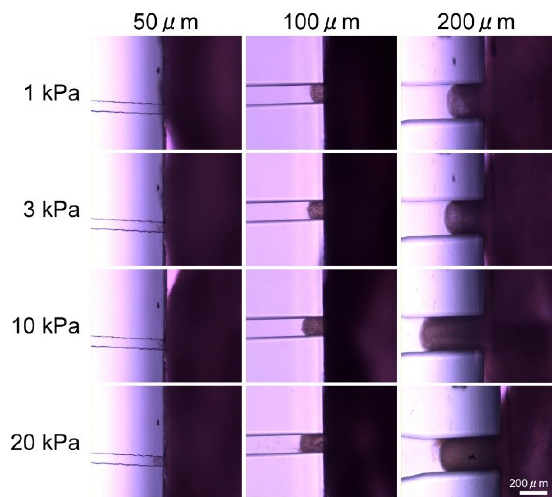
Figure 5. Photos of the normal human cardiac fibroblast (NHCF) 3D tissue that was pulled into the single‐hole micro vacuum chuck (MVC). The cross‐sectional shape of the vacuum hole was square and the side lengths were 50 μm, 100 μm and 200 μm. Applied vacuum pressures were 1 kPa, 3 kPa, 10 kPa, and 20 kPa. In each photo, a part of the NHCF 3D tissue was pulled into the hole. (Scale bar: 200 μm).